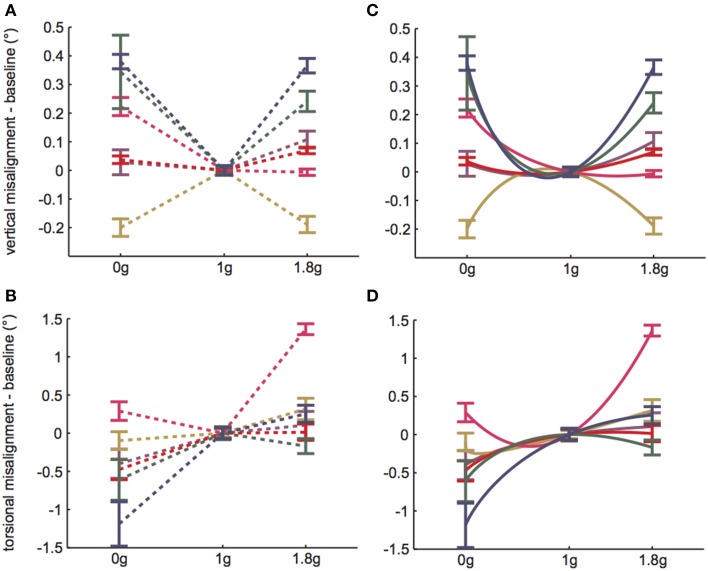
1 g baseline data subtracted from Early parabolic flight data for (A) VAN and (B) TAN. Dashed lines simply group data within subjects and do not represent actual (or proposed) g-level responses. (C,D) Solid lines represent model predictions, given b = 4a. Error bars are ±1SE.